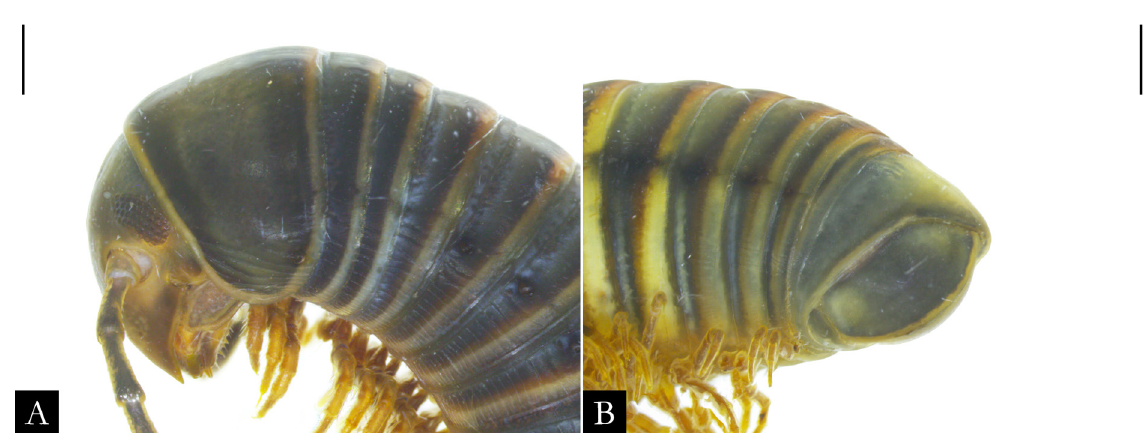
Fig. 68. Pseudonannolene fontanettiae Iniesta & Ferreira, 2014, ♀ (IBSP 3759), in lateral view. A . Anterior region. B . Posterior region. Scale bars = 1